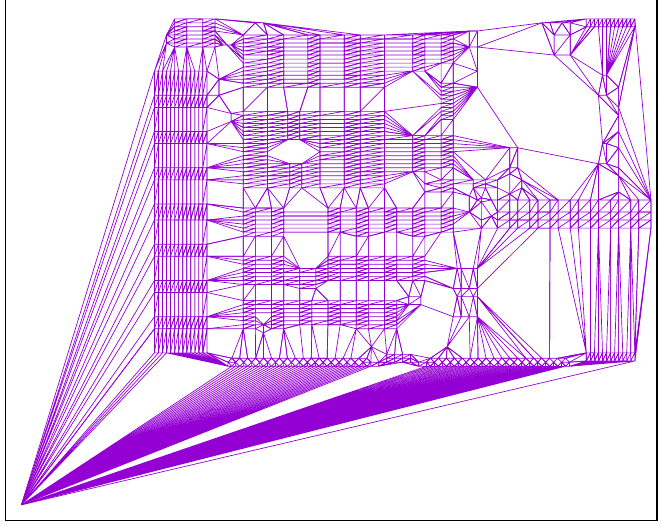
Figure 2. ResultingmeshwhenconsideringonlythefiveclosestcandidatesperpointforTSPinstance d1291